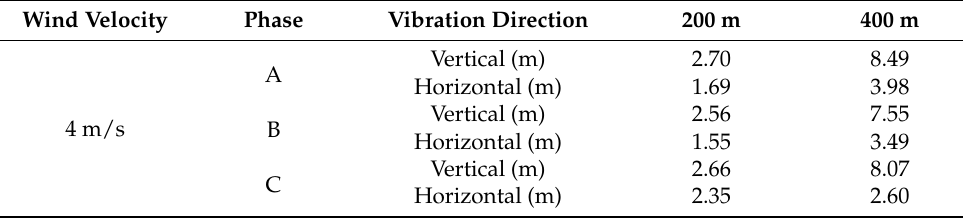
Table 5. Galloping amplitude of conductor with different span lengths in different wind